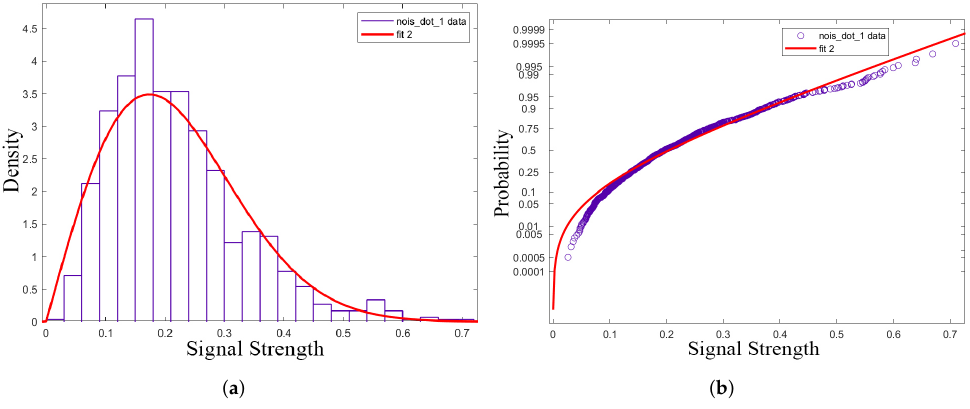
Figure 9. Simulation and fitting experiment example of RDM matrix noise density function ( a ) Noise distribution curve. ( b ) Matching degree of Rayleigh